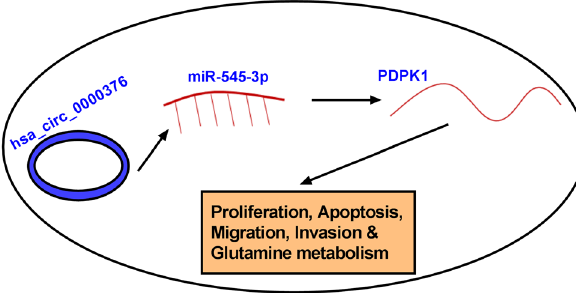
Figure 8: The schematic illustration showing the mechanism underlying circ_0000376 regulating NSCLC cell proliferation, migration, invasion, apoptosis, and glutamine